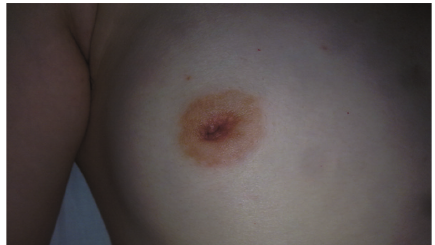
Figure 1: The nipple retraction was present, but there was no tenderness, redness, swelling, skin rupture, or nipple discharge.